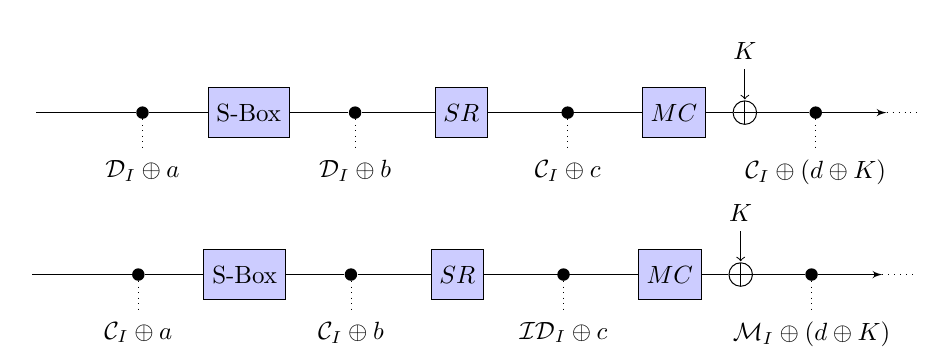
Figure 3: The essential subspaces in the AES